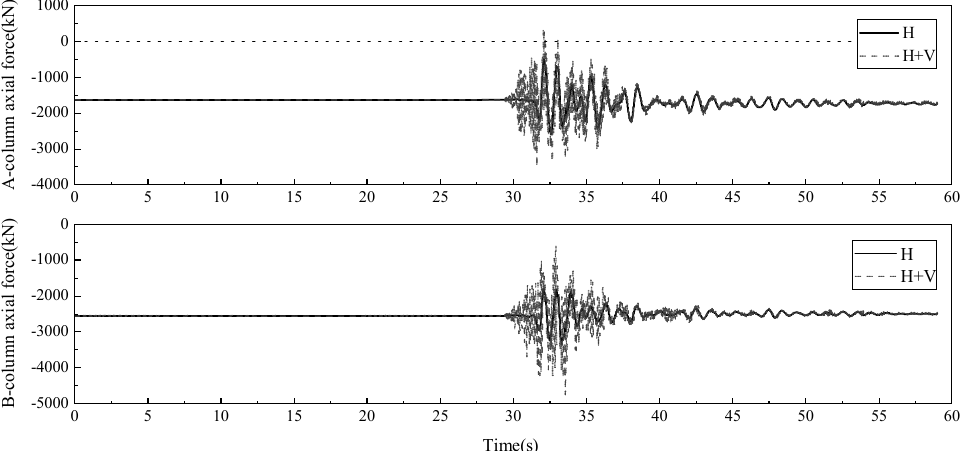
Figure 6. Time − history curve of A and B − column axial force under two conditions of Yangbi ground motion.